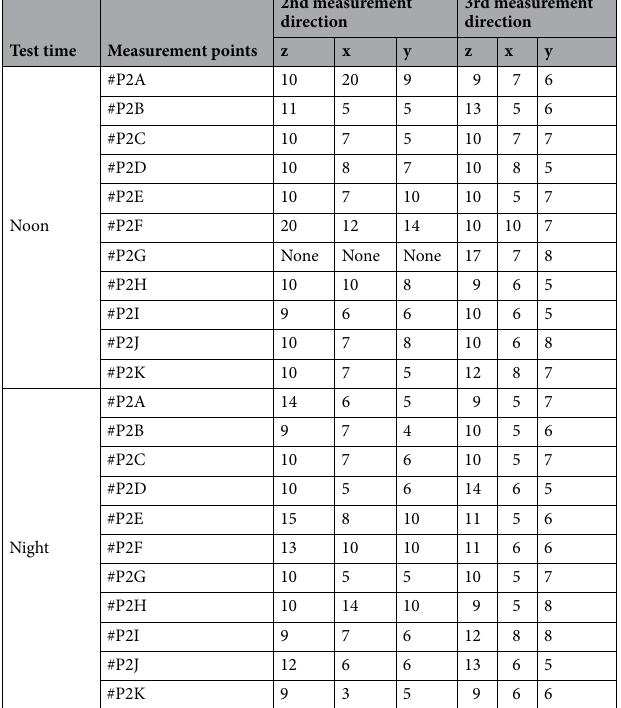
Table 3. Critical frequency of the significant separation point between the signals